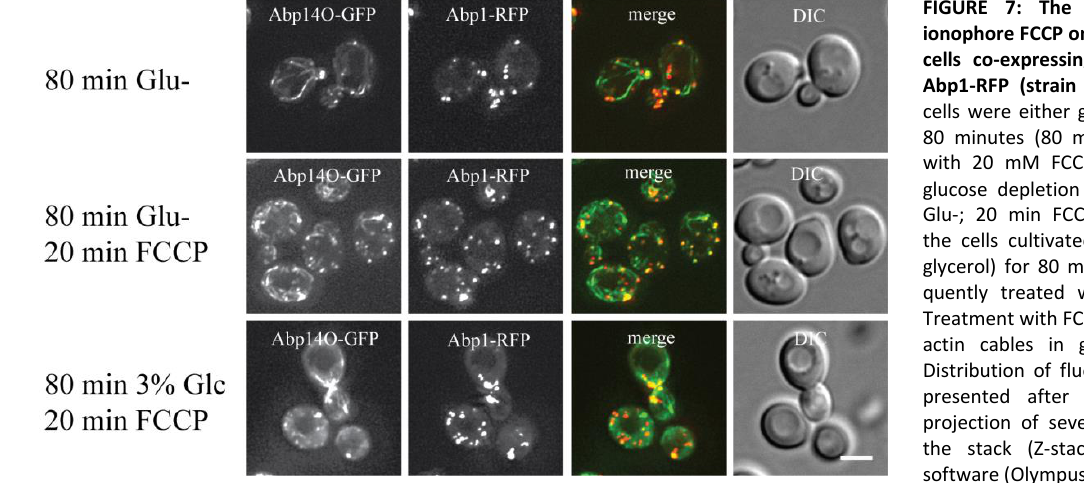
FIGURE 7: The effect of proton- ionophore FCCP on S. cerevisiae (rho + ) cells co-expressing Abp140-GFP and Abp1-RFP (strain CRY1337). The live cells were either glucose-depleted for 80 minutes (80 min Glu-) or treated with 20 mM FCCP for 20 min after glucose depletion for 80 min (80min Glu-; 20 min FCCP). For comparison the cells cultivated in 3 % YPG (3 % glycerol) for 80 min were also subse- quently treated with 20 mM